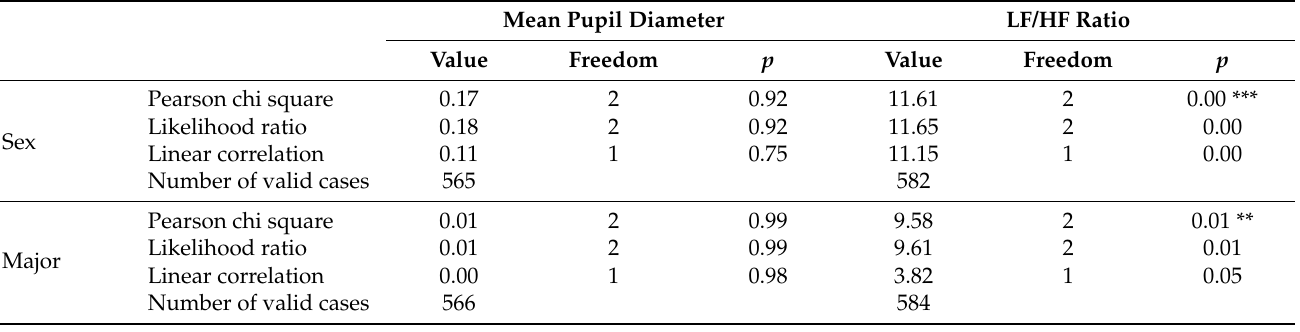
Table 2. Cross examination of psychophysiological variables.